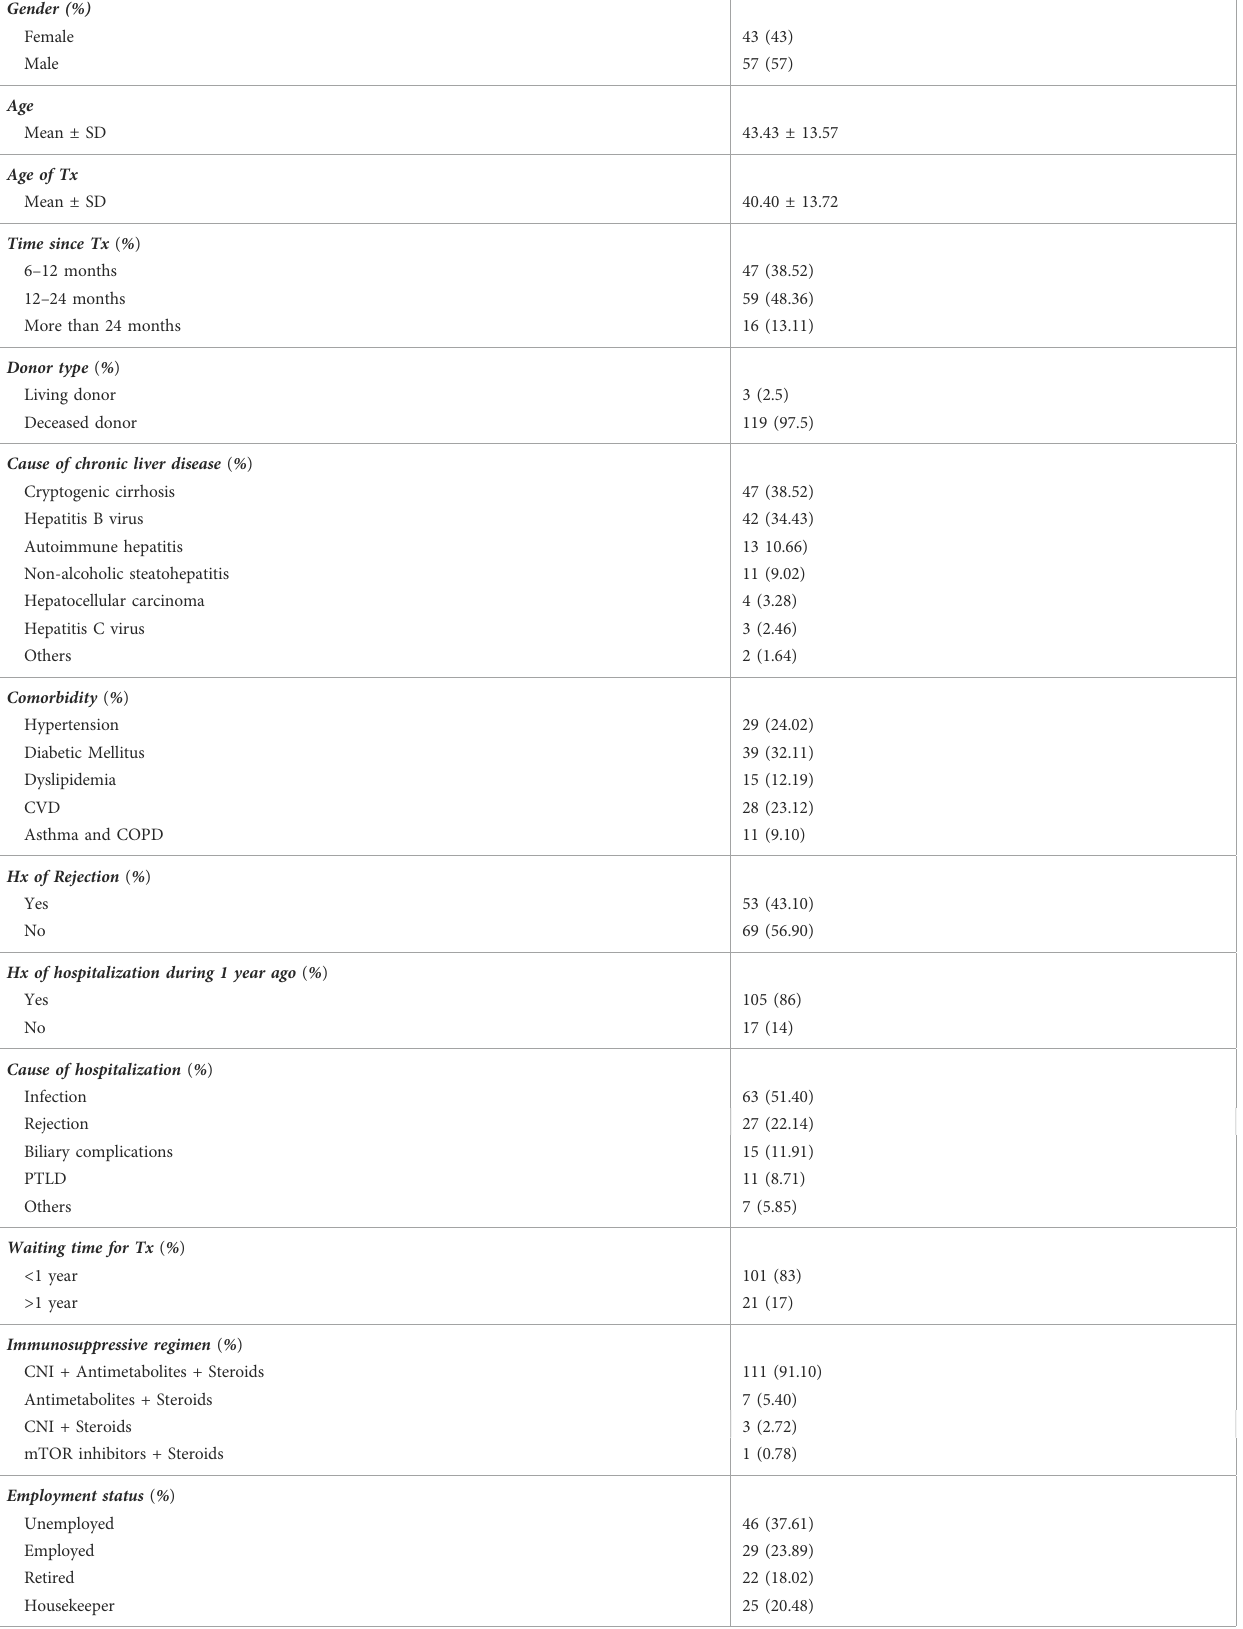
TABLE 1 Demographic, clinical, and social-economical-cultural properties of the liver transplant recipients (N = 122). Gender